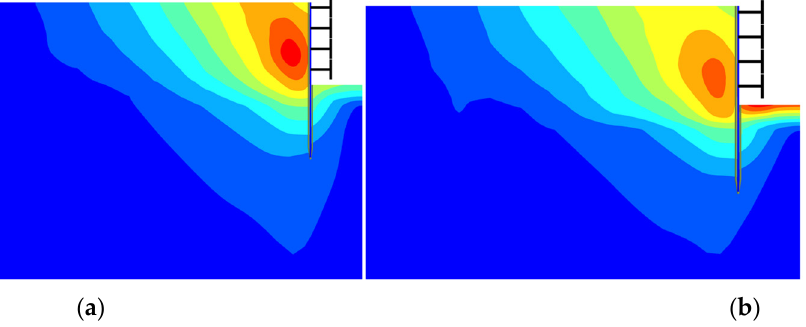
Figure 8. Effect of spatial variability on failure mode: ( a ) basal heave dominate; ( b ) wall deflection